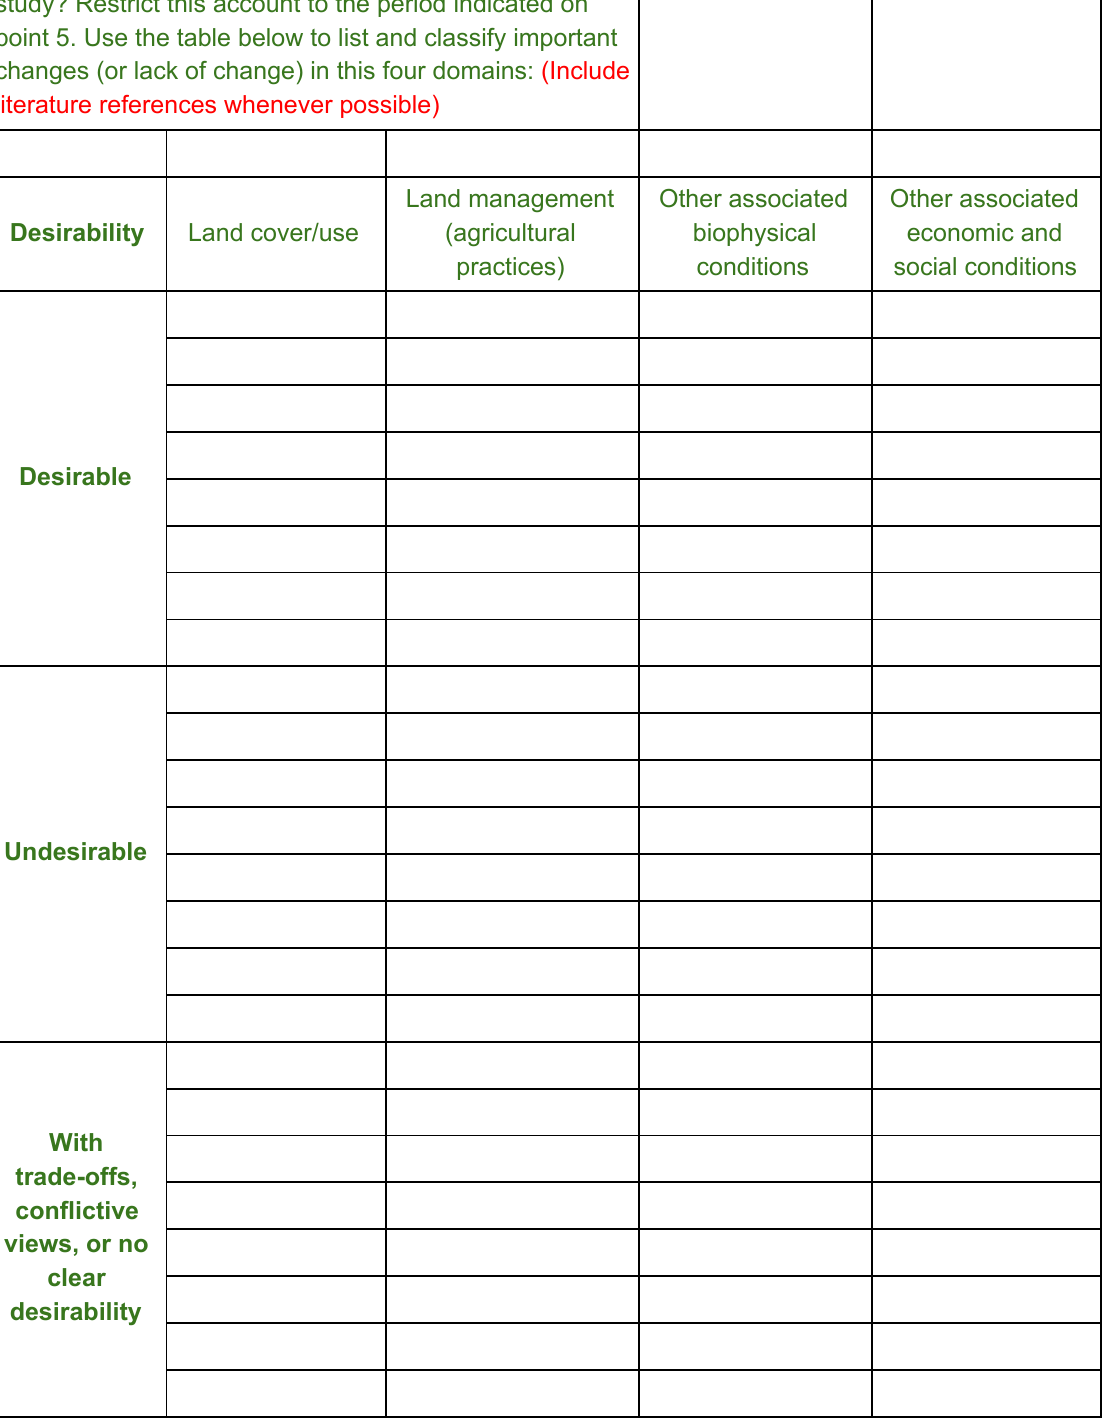
TABLE A 9a) In relation with point 7, what do you think are the ​​ most important observed trends that describe this case study? Restrict this account to the period indicated on point 5. Use the table below to list and classify important changes (or lack of change) in this four domains: literature references whenever